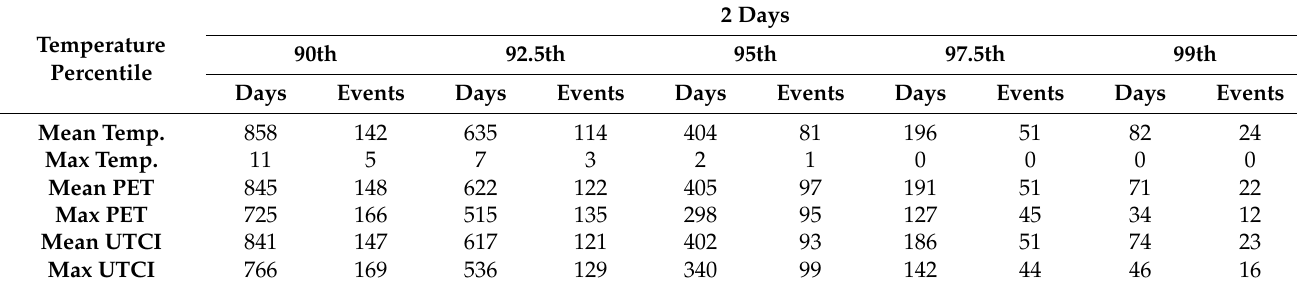
Table 3. Number of days and events for different percentiles for heatwave events (2 days).